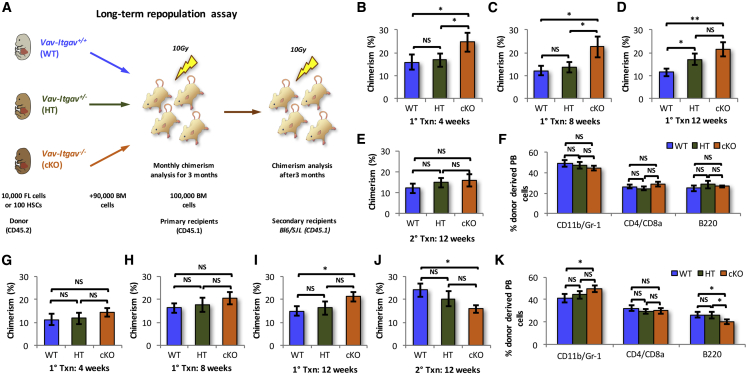
Vav-Itgav−/− HSCs Acquire Adult Phenotype During Engraftment and Show Functional Decline(A) Schematic representation of the competitive repopulation assay performed to assess the function and/or frequency of HSCs in FL tissue following Itgav deletion. A total of 10,000 whole FL cells from WT, HT, and cKO embryos along with 90,000 whole BM competitor cells (CD45.1) were transplanted into lethally irradiated WT CD45.1 mice. Alternatively, the assays were performed using sorted primitive HSCs. One hundred CD150+CD48−KLS cells together with 100,000 whole BM competitor cells (CD45.1) were transplanted into sub-lethally irradiated WT CD45.1 mice. Peripheral blood (PB) chimerism and multi-lineage engraftment was followed for 12 weeks, after which secondary transplantations were performed. Secondary recipients were analyzed after 3 months of transplantation.(B–D) PB chimerism in primary recipients compared after 4 weeks (B), 8 weeks (C), and 12 weeks (D).(E) PB chimerism in secondary recipients after 12 weeks of transplantation.(F) Multi-lineage engraftment for myeloid (CD11b/Gr-1), T cell (CD4/CD8), and B cell (B220) lineage in secondary recipients after 12 weeks of transplantation.(G–I) Chimerism analysis of primary recipients transplanted with 100 sorted HSCs from WT, HT, and KO embryos, together with 100,000 competitor cells. PB chimerism was analyzed after (G) 4 weeks, (H) 8 weeks, and (I) 12 weeks of transplantation.(J) Chimerism analysis of the secondary recipients transplanted with the BM cells of primary recipients that received freshly sorted HSCs. PB chimerism was analyzed after 12 weeks of transplantation.(K) Multi-lineage engraftment in secondary recipients after 12 weeks of transplantation. Analysis was performed for myeloid (CD11b/Gr-1), T cell (CD4/CD8), and B cell (B220) lineages.An unpaired two-tailed Student's t test was performed. n = 3, N = 15–18, t test: ∗p < 0.05, ∗∗p ≤ 0.01, NS, not significant.